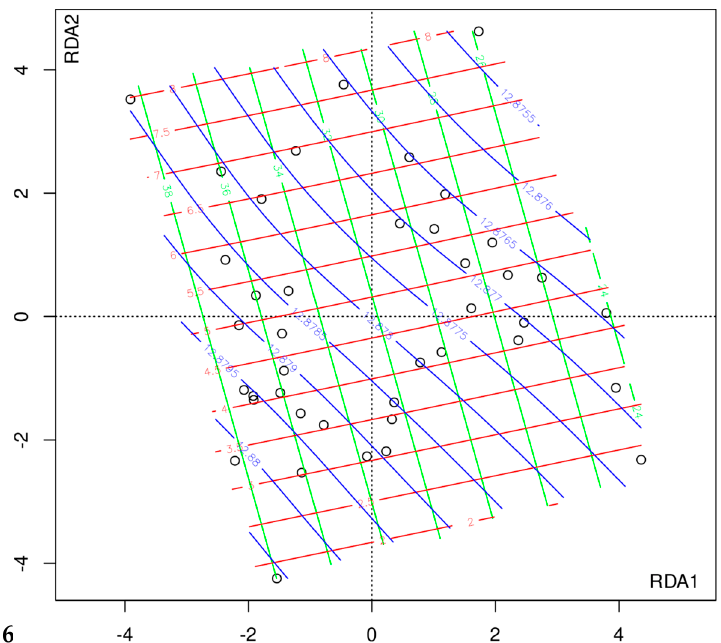
Figure 4. Relationship between the composition of the intestinal microbiota and Beck’s score, and the concentration of isobutyric acid and acetate in the stool. Black circles—individual patients; blue color line—Beck’s scale value; red color—the concentration of isobutyric acid in the stool; green—the concentration of acetate in the stool. The increase of the Beck sum of points (blue line) is associated with a decrease in stool isobutyric acid (red line) and an increase in stool acetate (green line).